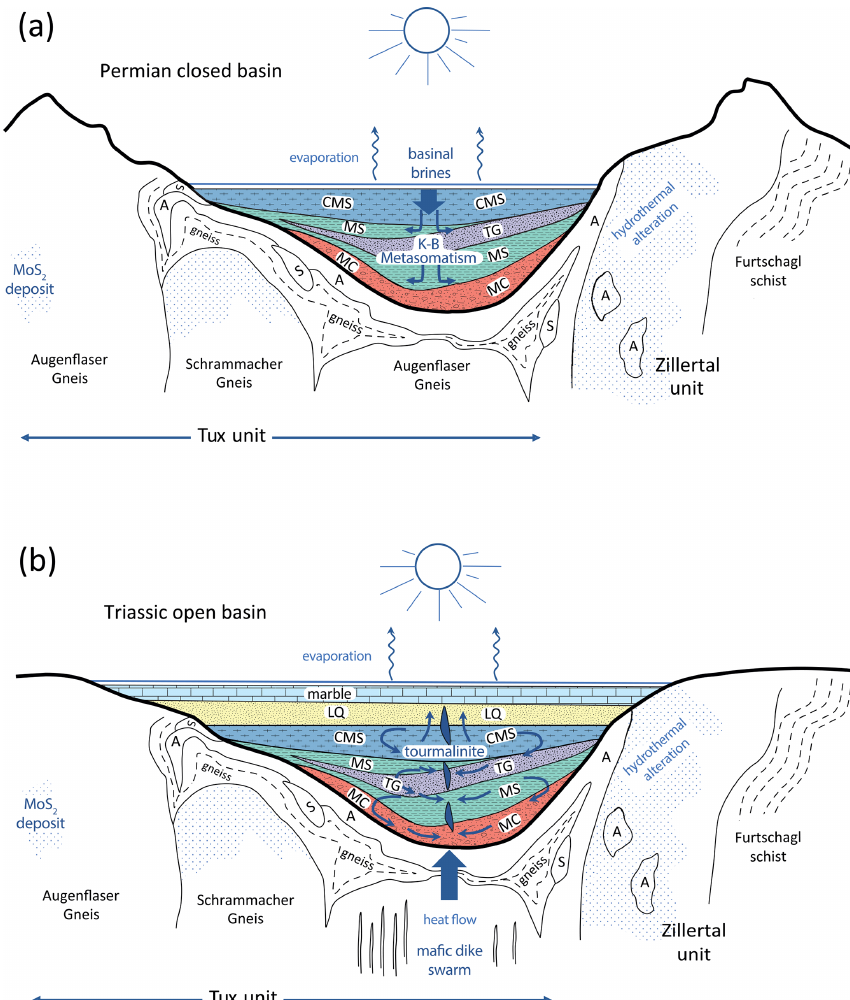
Figure 9. Schematic cross sections of the Pfitsch–Mörchner basin at the Permian (a) and Triassic (b) (not to scale). Sedimentation of the Pfitsch Formation started with coarse conglomerates (preserved as metaconglomerate, MC) from proximal source rocks, the Variscan mountain chain with dominantly granites, partly with hydrothermal alteration (e.g., the molybdenite deposit at the Alpeinerscharte; cf. Fig. 1) in the Tux unit. The roof pendant of the granites consists of gneiss, amphibolite (A), and serpentinite (S). During the Permian, the sedimentary protoliths (especially for tourmaline gneiss, TG, and mica schist, MS, and carbonate–mica schist, CMS) of the closed, intramontane basin with evaporitic deposits were influenced by diagenetic descending, highly saline brines, which caused K and B metasomatism. The Triassic marks the transition from a closed to an open basin with deposition of well-sorted (distal transport) conglomeratic phosphatic sandstone (protolith of the lazulite quartzite, LQ, Windtal Formation), possibly connected with a disconformity, overlain by shallow-water carbonates (Aigerbach Formation marble horizon). Formation of tourmalinite veins is due to hydrothermal circulation of B-rich pore waters in the basin. Increased heat flow in the basin is produced by intrusion of mafic dikes into the Tux branch of the